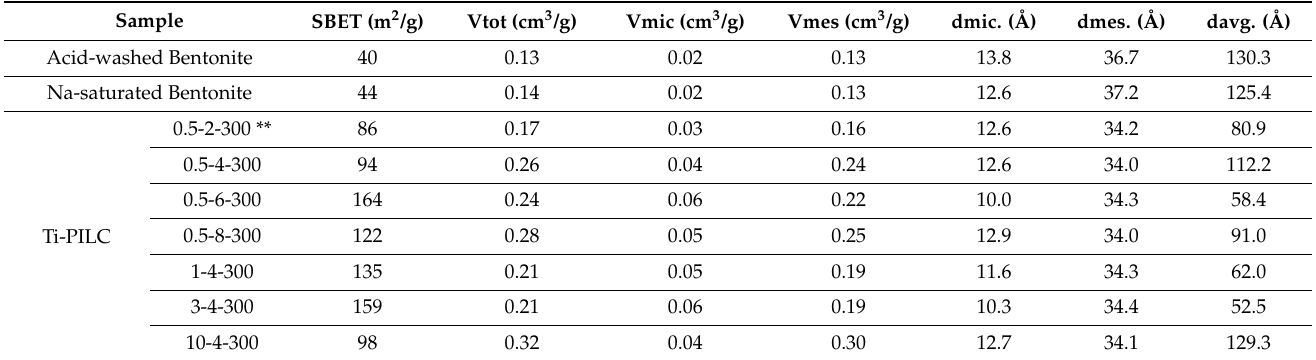
Table 3. Porous properties of Ti-PILCs obtained at different operating conditions in comparison with the acid-washed and Na-saturated bentonites